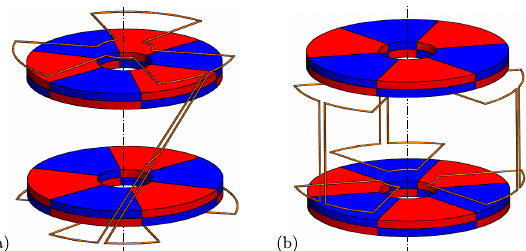
Figure 1. Bearing topologies with only one phase represented: ( a ) PMs are internal and the p coils of each set are connected in series, the two resulting sets being connected together in series; and ( b ) PMs are external and the p upper and the p lower coils are independently connected together in